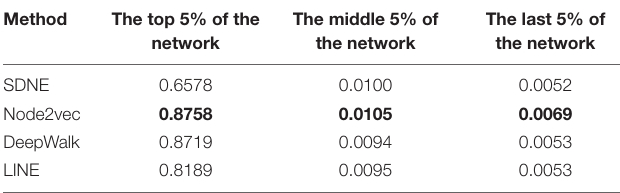
TABLE 3 | AUCPR value of Human protein similarity prediction.